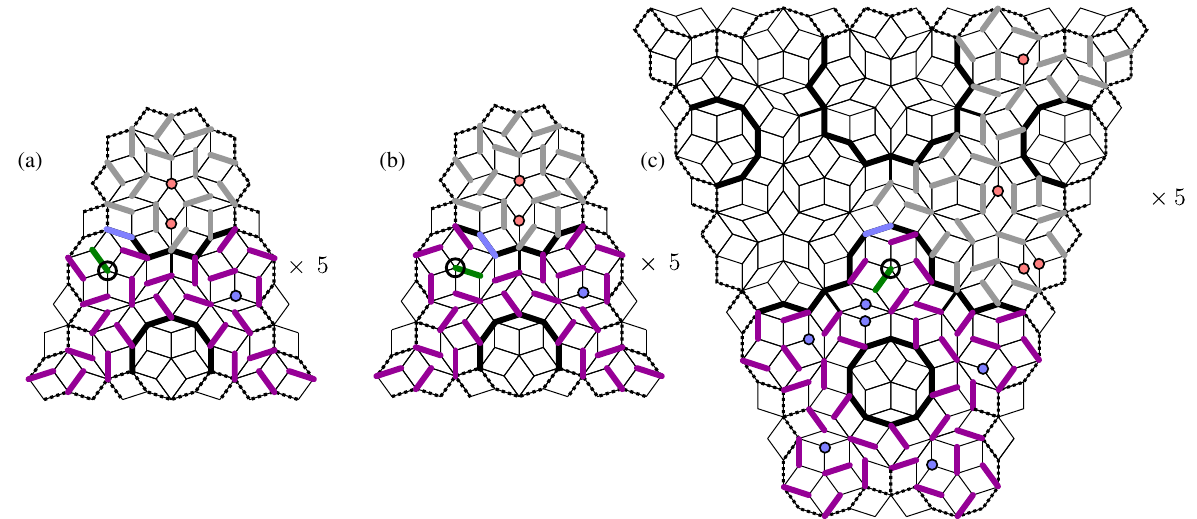
FIG. 22. Proof that, of the edges emanating from a 4-vertex, only the edges indicated in Fig. 6(b) may host dimers. See accompanying text in Appendix A 2 and Fig.